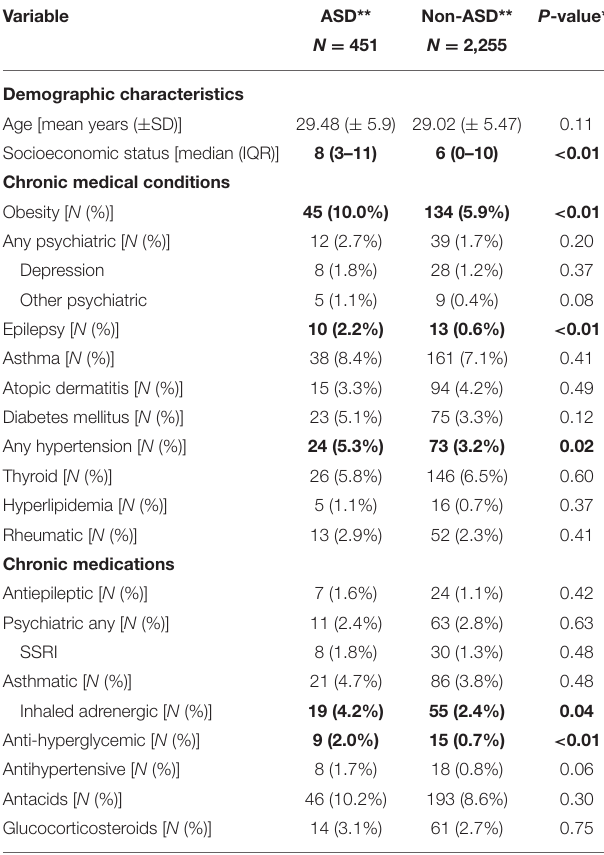
TABLE 1 | Demographic and clinical characteristics of mothers of children with ASDs and matched non-ASDs controls * .